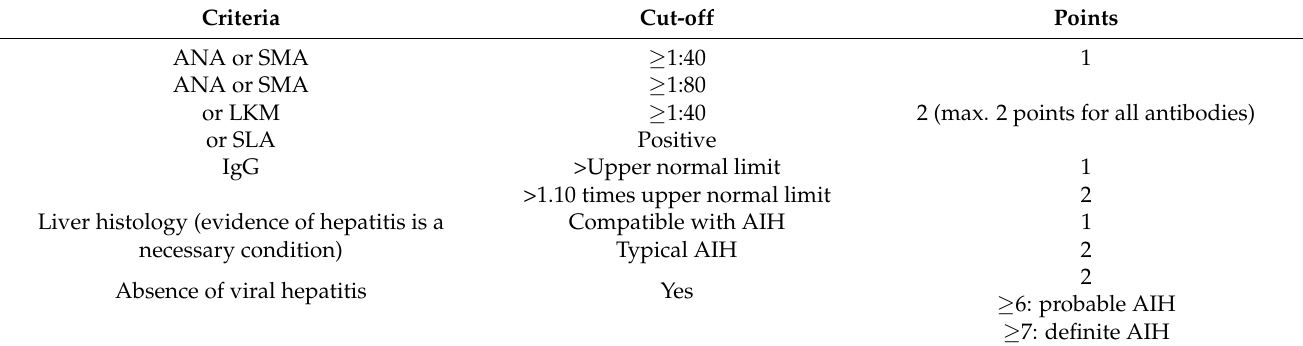
Table 2. Simplified diagnostic criteria for AIH (created in accordance with Hennes et al. [36]). Criteria